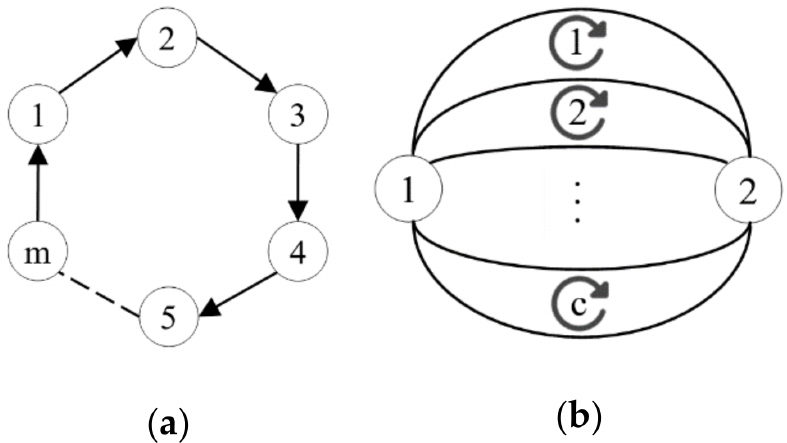
Figure 1. Examples of analytical circuit models where one of the methods is deemed more preferable than the other: ( a ) LM; ( b )